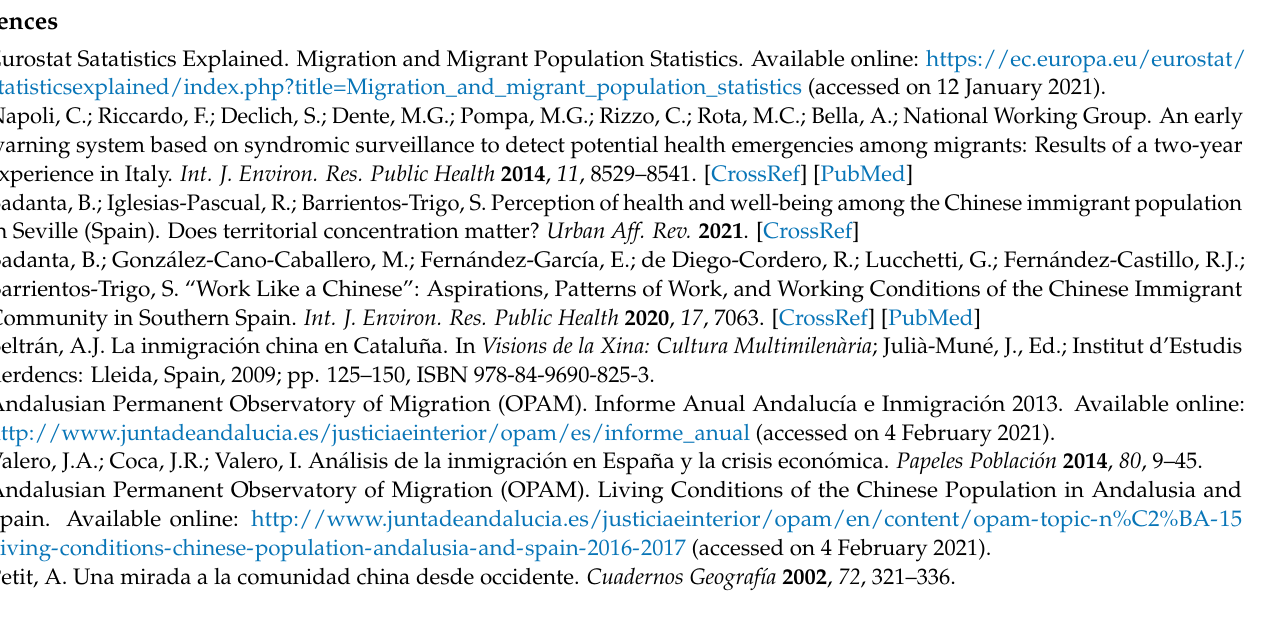
Table S2: Consolidated criteria for reporting qualitative studies (COREQ): 32-item